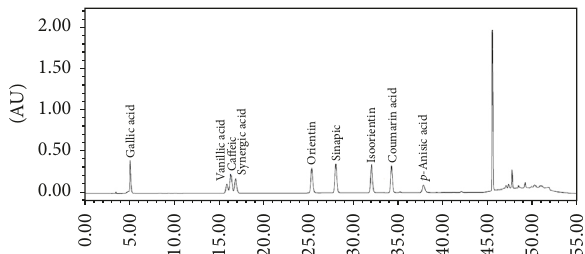
Figure 1: Chromatogram of phenolic compound mixture of the standards detected at 280 nm by RP-HPLC. Standards were gallic acid, vanillic acid, caffeic acid, synergic acid, orientin, isoorientin, sinapic acid, coumarin acid, and p -anisic